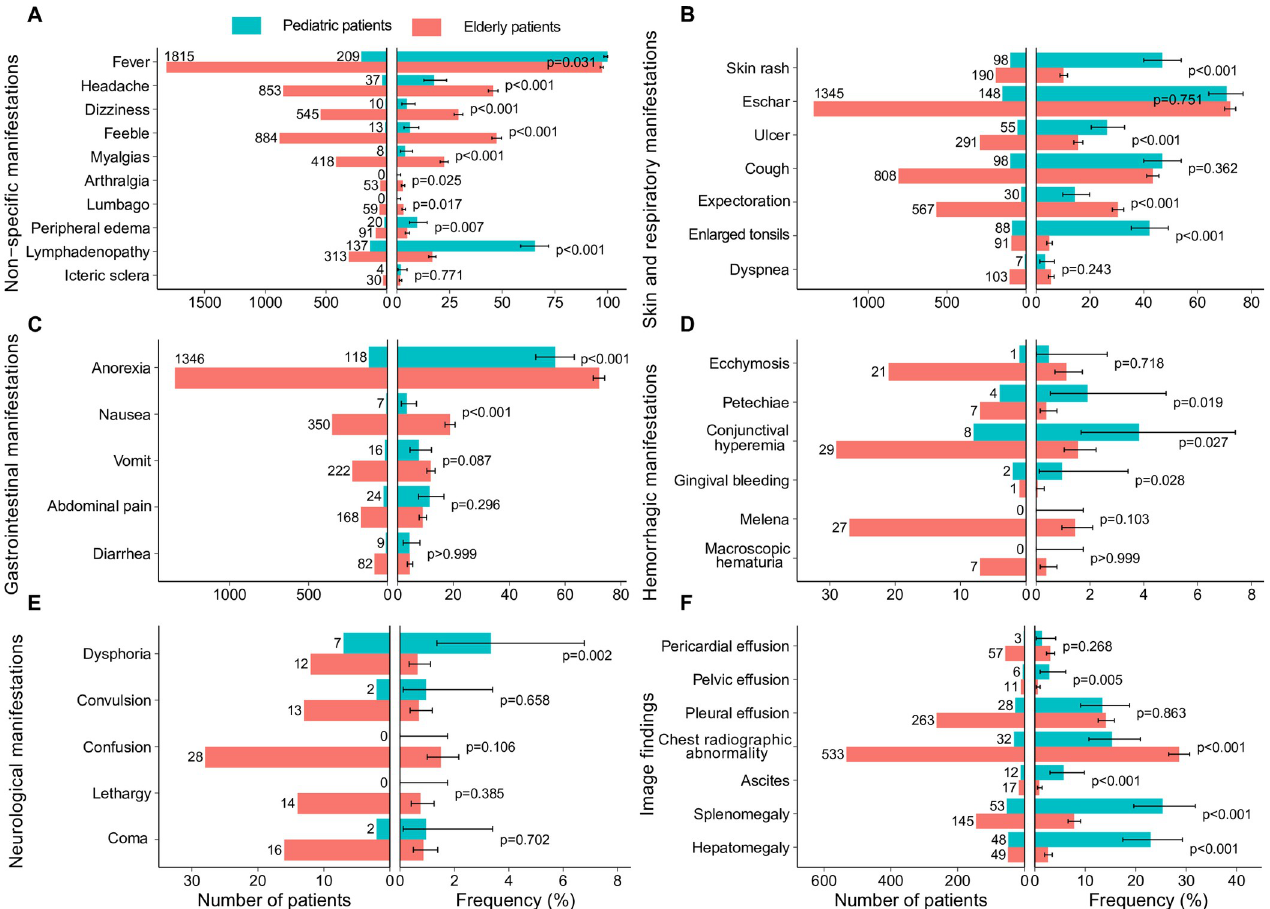
Fig 1. The clinical characteristics compared between pediatric and elderly patients with scrub typhus disease in Guangzhou, China. The case number and frequency of patients who reported each of the pre-designed clinical manifestations were presented for pediatric group (0–14 years) and elderly group ( � 60 years) patients separately. The clinical manifestations were grouped into non–specific manifestations (A), skin and respiratory manifestations (B), gastrointestinal manifestations (C), hemorrhagic manifestations (D), neurological manifestations (E), and image findings (F). p value indicated comparison of frequencies between pediatric and elderly patients for each pre-designed clinical manifestation by use of χ 2 test or Fisher’s exact test.